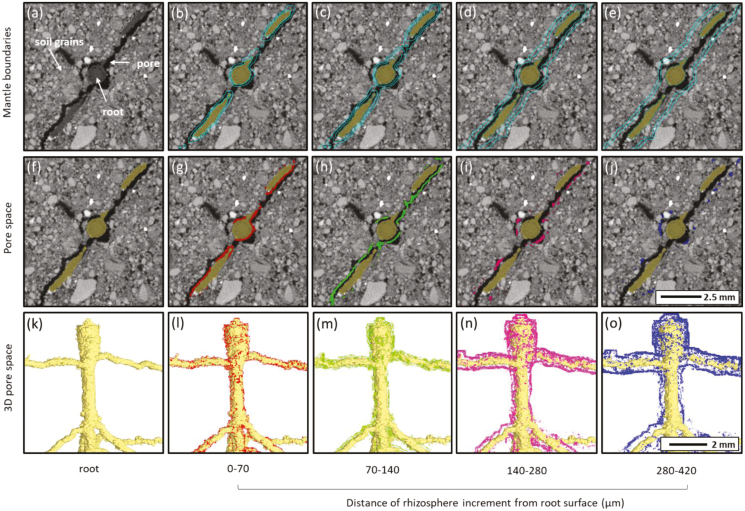
Delineation of rhizosphere zones, and examples of 2D and 3D identification and visualisation of pore spaces for Cirsium vulgare. The images were produced using VGStudio MAX v.2.2.5. (a) Original greyscale imagery at Day 28 with root, pore space, and soil indicated. In the other colour images, the root appears as olive green. (b–e) Boundaries of the incremental zones (referred to ‘mantles’), depicted by the blue lines. The zones are indicated at the bottom of the figure. (f–j) Pore spaces in the mantle zones. Different colours correspond to differences in distance from the rhizosphere. (k–o) 3D representations of soil porosity in the mantle zones. Different colours correspond to differences in distance from the rhizosphere.